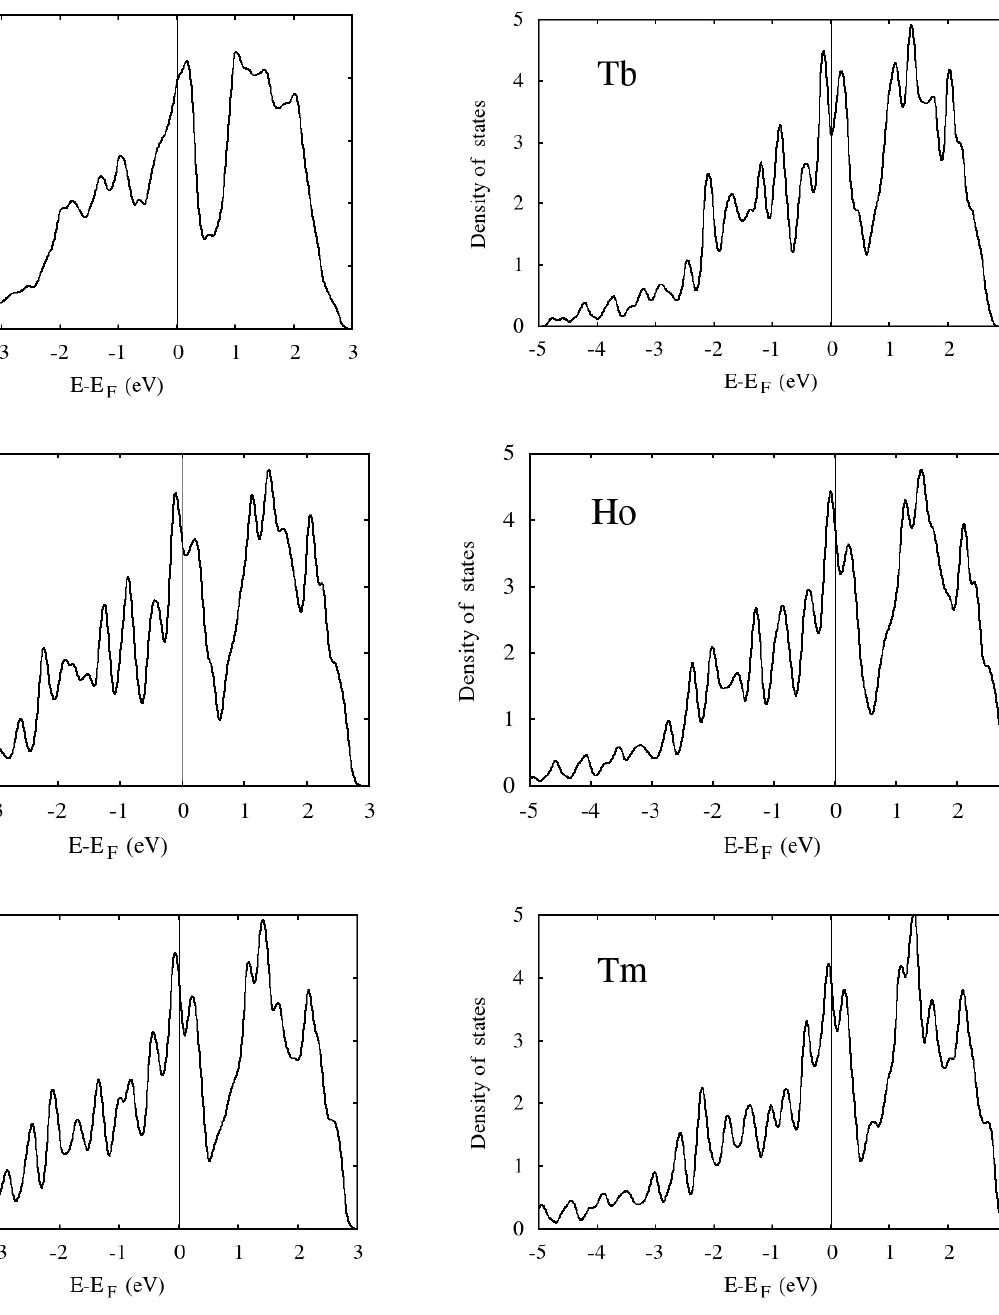
Figure 1. The density of states (DOS) of heavy lanthanides Gd, Tb, Dy, Ho, Er, Tm. The plots show that at E = E F the DOS value is maximal or close to maximal. This insignificant change in the Fermi energy is because the concentration of free electrons per unit volume changes weakly in the series of heavy REM from gadolinium to thulium. In [40] it was predicted that the periodic electronic structure caused by the s-f interaction, which determines the magnetic properties of the considered metals, affects the shape of the Fermi surface. Self-intersections of the Fermi surface take place even in the case of infinitesimal perturbation. Thus, the exchange interaction, by removing degeneracy, leads to the splitting of the peaks in the figure n and to the formation of non-intersecting cavities of the Fermi surface. It also follows from the aforementioned work that the half-width of the energy gap between peaks is proportional to the integral of the s-f interaction and to